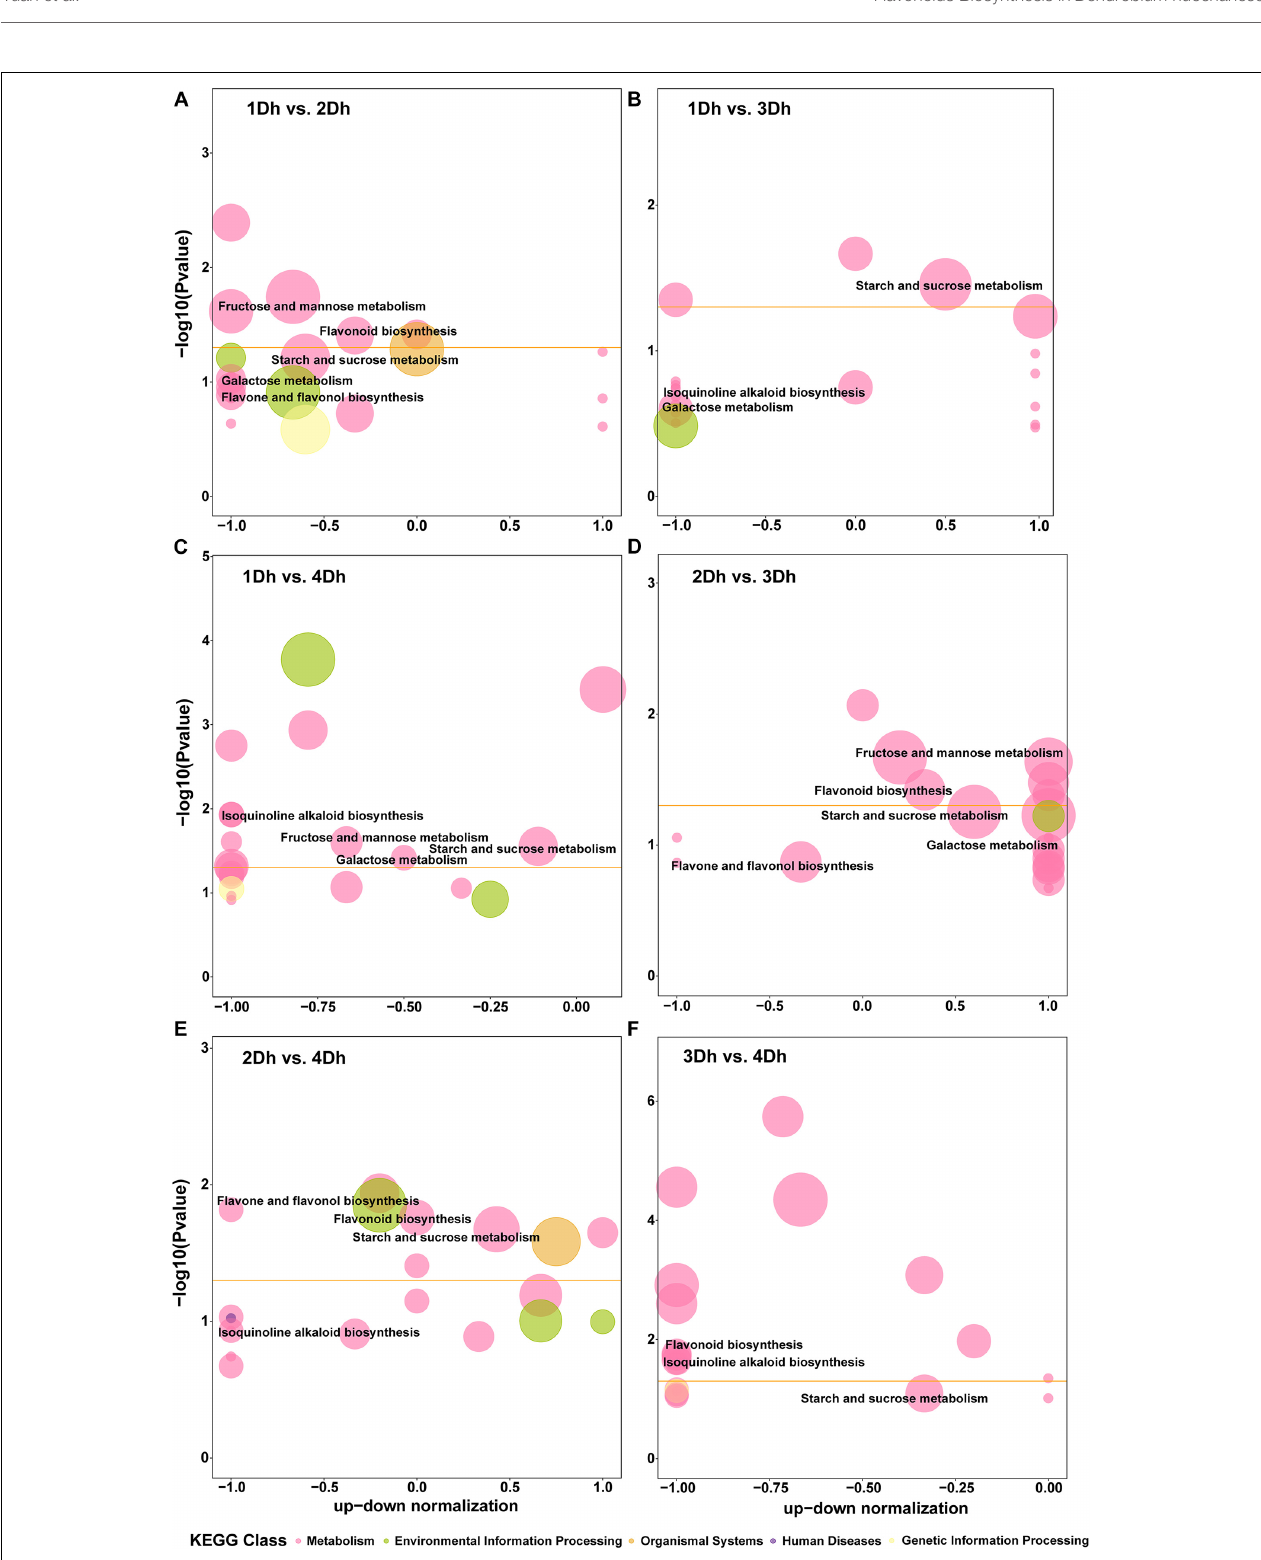
FIGURE 3 | KEGG pathway enrichment bubble diagram. The horizontal axis is the up-down normalization and the vertical axis is the –log 10 ( P -value). The size of the bubble represents the number of the target DEGs and the color of the bubble represents different KEGG classes. The threshold line in orange is P- value = 0.05. (A) 1Dh vs. 2Dh. (B) 1Dh vs. 3Dh. (C) 1Dh vs. 4Dh. (D) 2Dh vs. 3Dh. (E) 2Dh vs. 4Dh. (F) 3Dh vs.